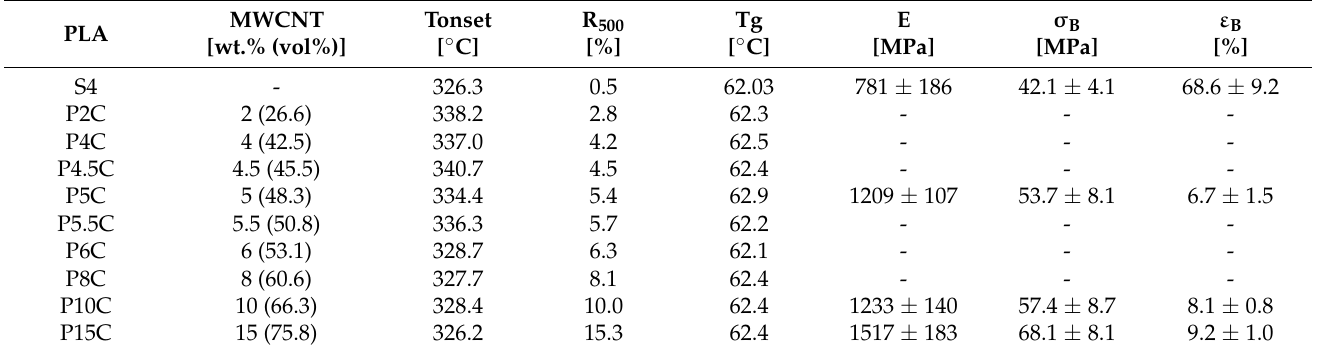
Table 3. MWCNT optimization study samples compositions, TGA, DSC, and tensile strength test